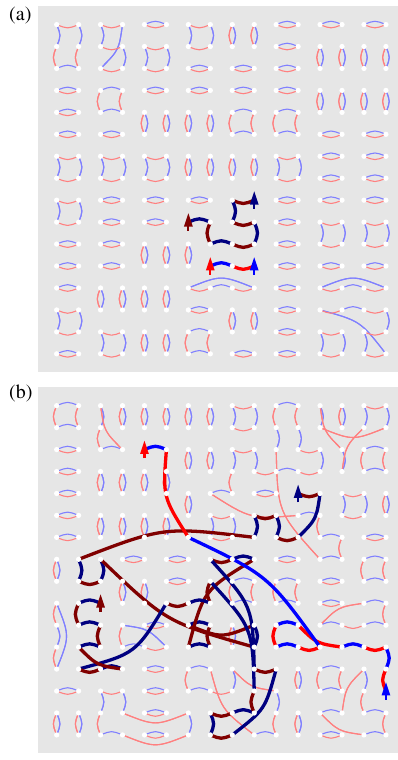
FIG. 6. Transition graphs in the S ¼ 1 ground state of an L ¼ 16 J - Q system without disorder in the VBS (a) and AFM (b) phase. For clarity, open boundaries are used here to avoid bonds crossing the boundaries. Red and blue arches correspond to bra and ket valence bonds, with thicker bonds representing the two open strings (depicted in different color shades for clarity) that terminate at unpaired spins (one in the bra and one in the ket state). These end spins are always on sublattice A in one of the strings and B in the other one. In (a), defects in the columnar symmetry-broken VBS pattern originate both from the presence of the spinons and by the intrinsic VBS fluctuations. Formation of a clearly columnar state can be observed only for much larger system sizes